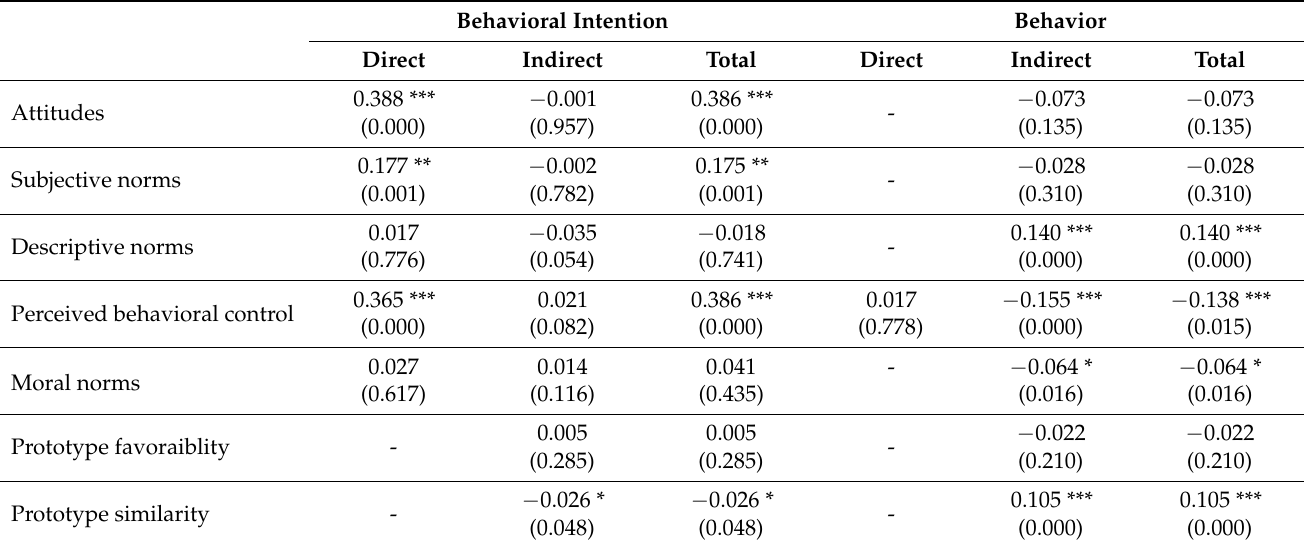
Table 5. Direct and indirect effects of the integrated